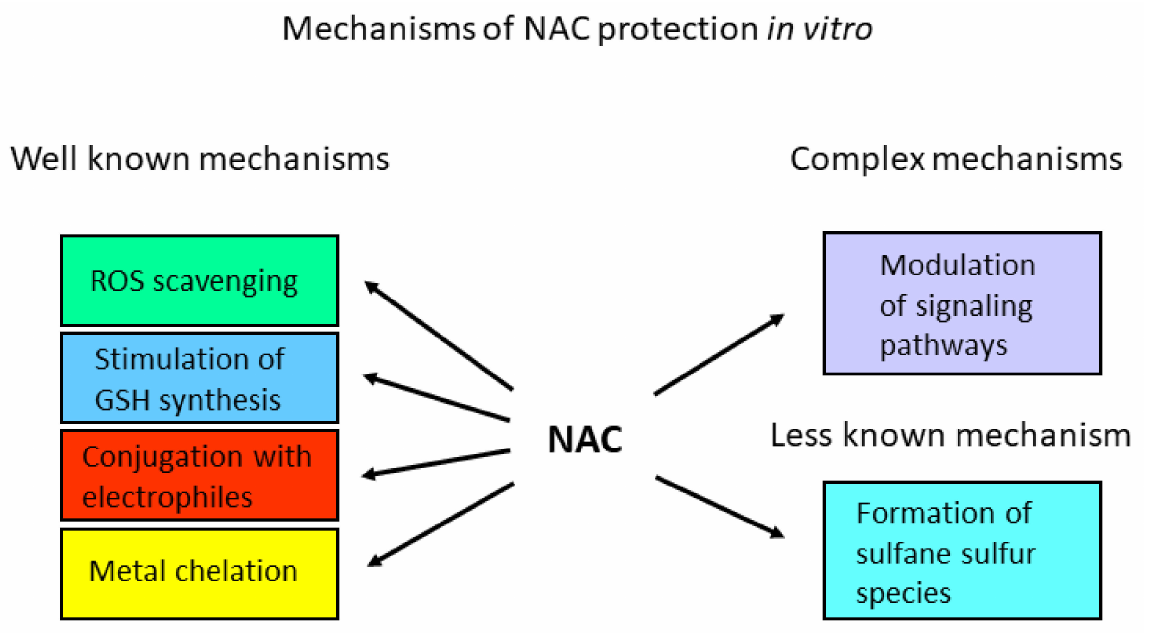
Figure 1. Mechanisms of NAC protection in vitro known so